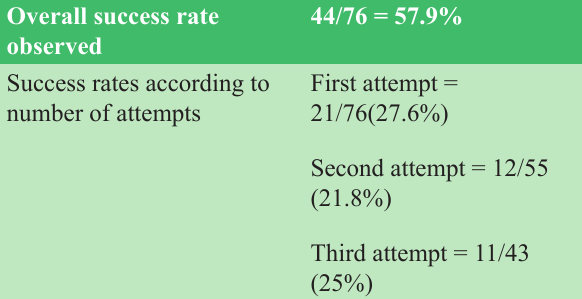
Table 3: Success rates of ABP.